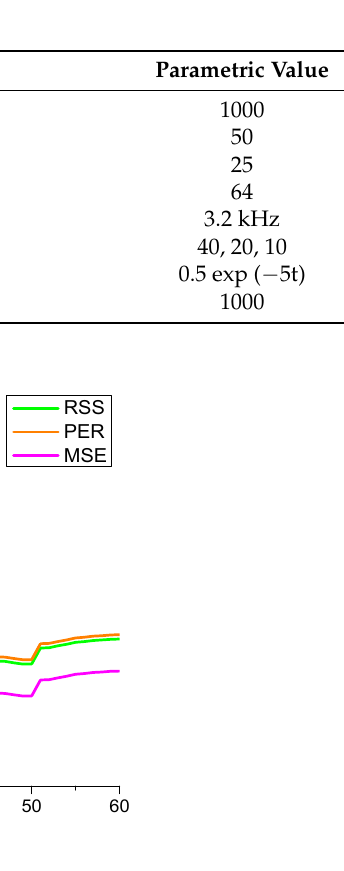
Figure 5. Flowchart of GWO-LS Harmonic Estimator. Figure 5. Variation of evaluation parameters of RSS, PER and MSE with respect to searching